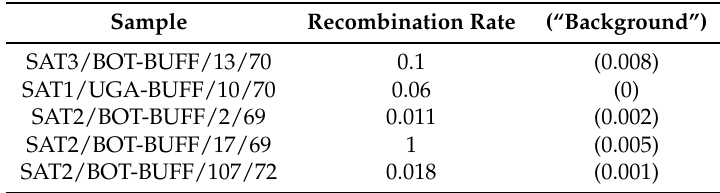
Table 2. Average recombination rates per site in each sample, normalized with respect to the highest average recombination rate. Background values represent an estimate of the spurious signal due to sequencing errors or multiple mutations.